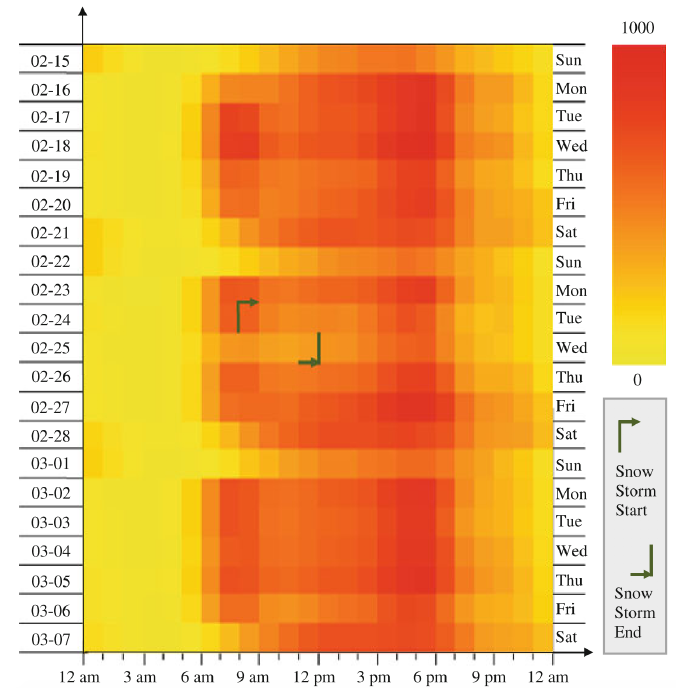
Figure 2. A heat map matrix visualization for traffic congestion analysis